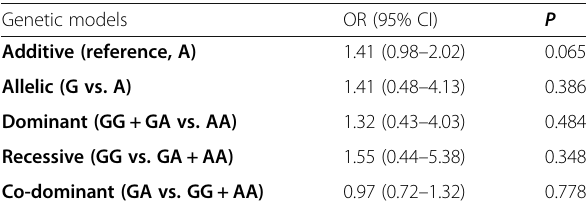
Table 2 Association of rs1126748 with dental caries